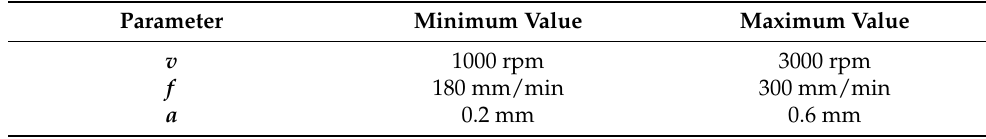
Table 1. Experiment parameters